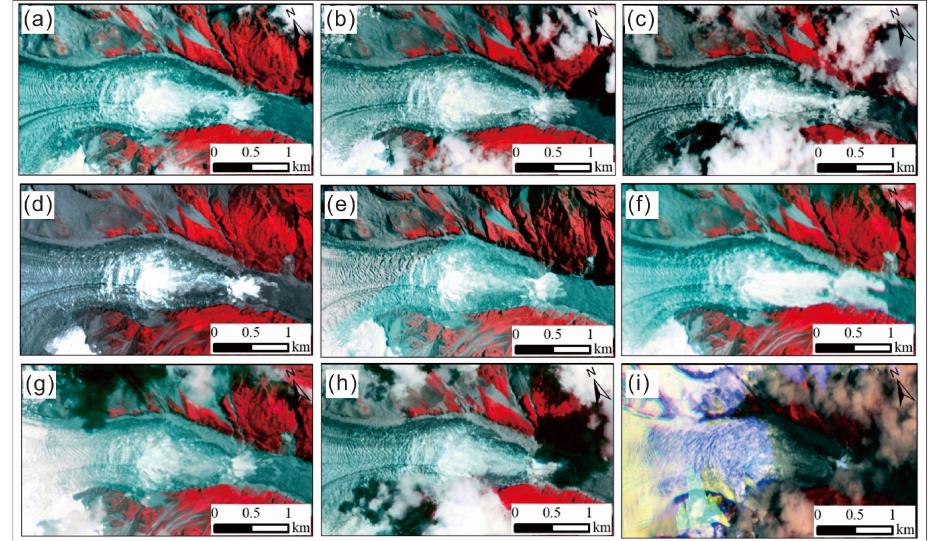
Figure 5. Changes of the ice cascade in the multi-temporal Planet satellite images. The shooting dates were ( a ) 17 August 2016, ( b ) 8 August 2017, ( c ) 31 August 2018, ( d ) 16 August 2019, ( e ) 26 August 2020, ( f ) 3 August 2021, ( g ) 29 July 2022, ( h ) 21 August 2022, and ( i ) 12 September 2022. The false color images (near-infrared, red, and green bands combination) distinguish the glaciers (in blue-green color) and vegetation (in red color), and they emphasis the occurrence of ice avalanche (in white